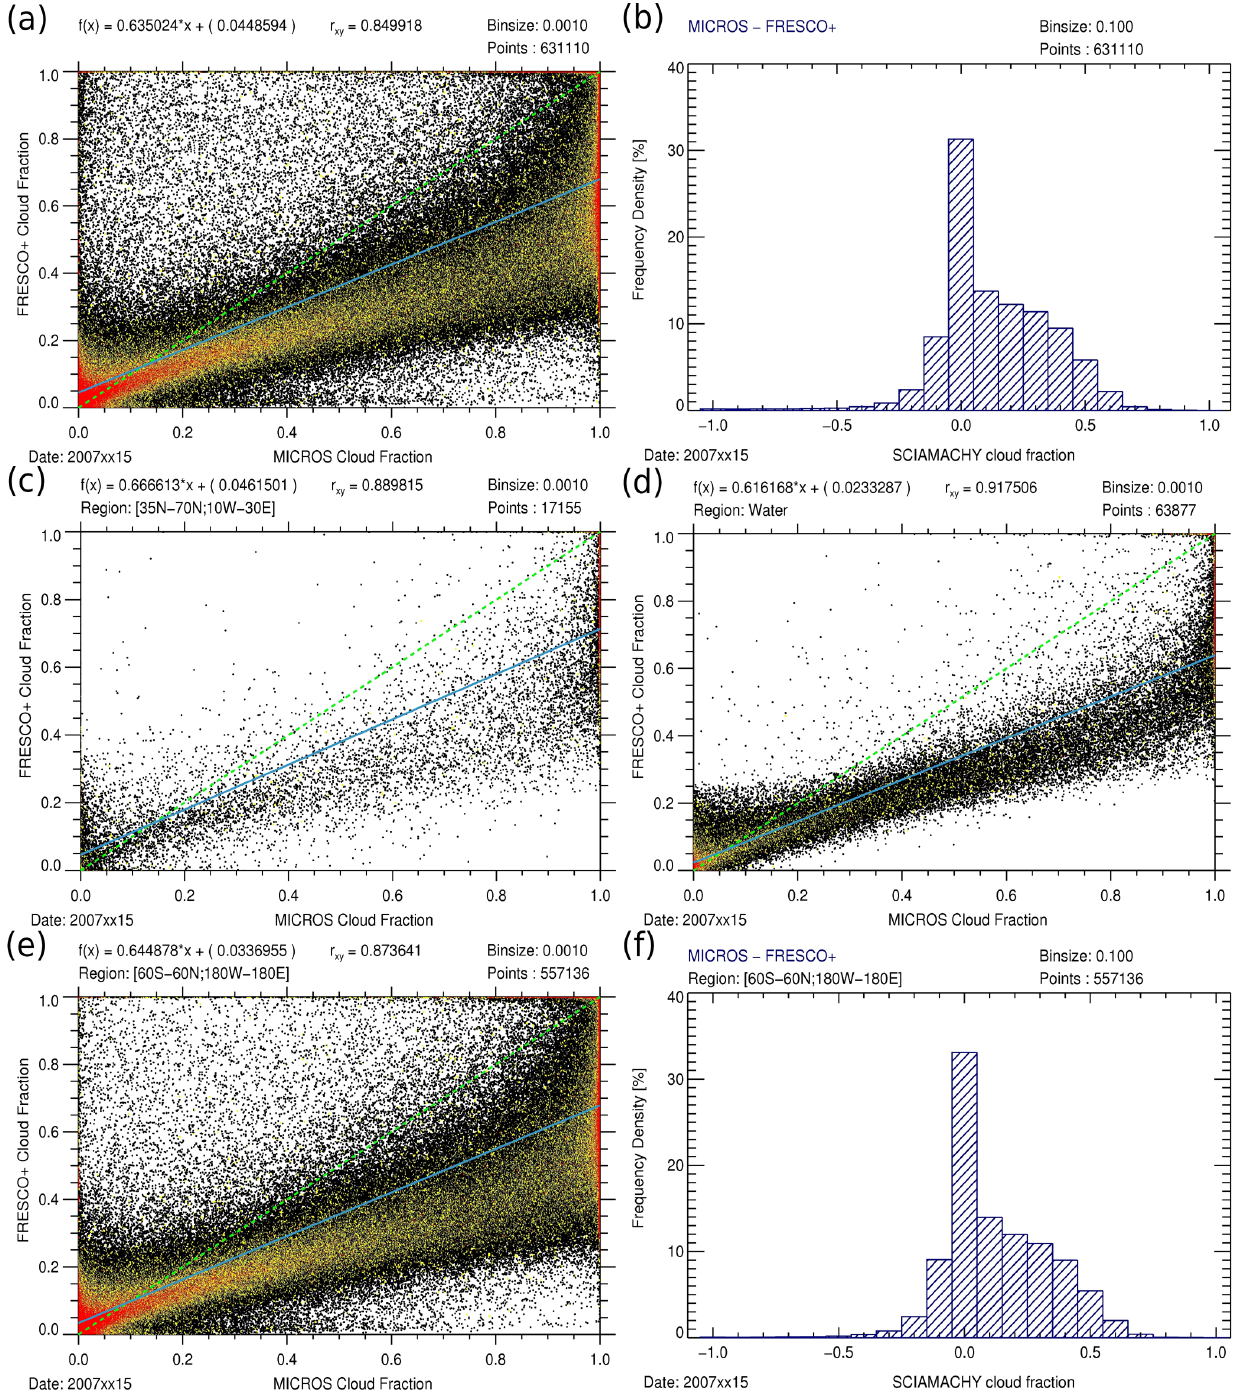
Fig. 10. Intercomparison of SCIAMACHY cloud fractions derived from the MICROS (optically thick clouds) and FRESCO+ algorithms considering each 15th in 2007: (a) Cross-validation for all cloud fractions, (b) difference histogram with respect to (a) , (c) cloud fractions over Europe [35 ◦ N–70 ◦ N; 10 ◦ W–30 ◦ E], (d) cloud fractions over water, (e) cloud fractions at mid- and low-latitudes [60 ◦ S–60 ◦ N; 180 ◦ W– 180 ◦ E] and (f) difference histogram with respect to (e) . The colour code of the two dimensional density function plots [ (a) , (c) , (d) , (e) ] is the following: If only one measurement is located inside of a bin, the result is coloured in black. If more than 1 but less than 4 measurements are located inside of a bin, the result is coloured in yellow. If more than 4 measurements are located inside of a bin, the results is coloured in